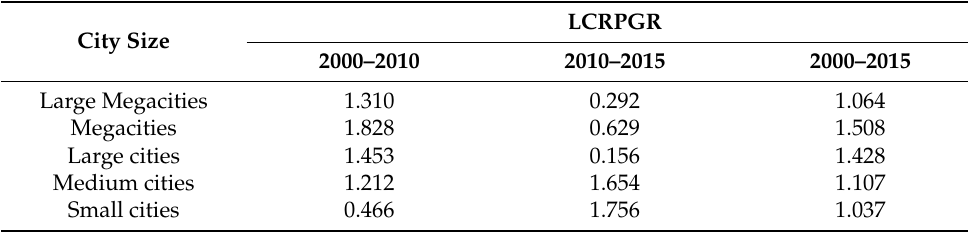
Table 4. The classification results of LCRPGR.